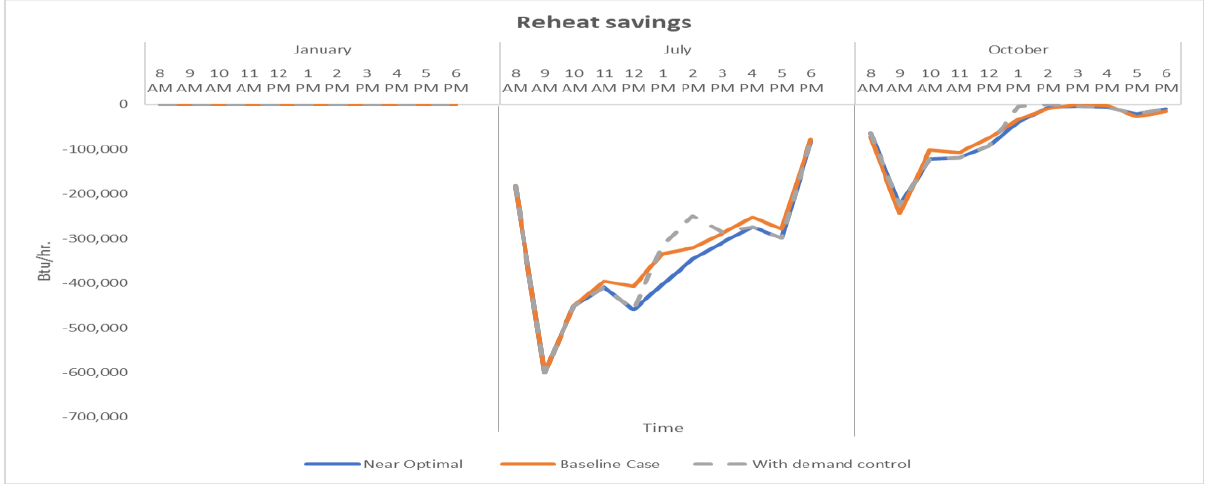
Figure 16. The reheat energy savings for each day being analyzed.